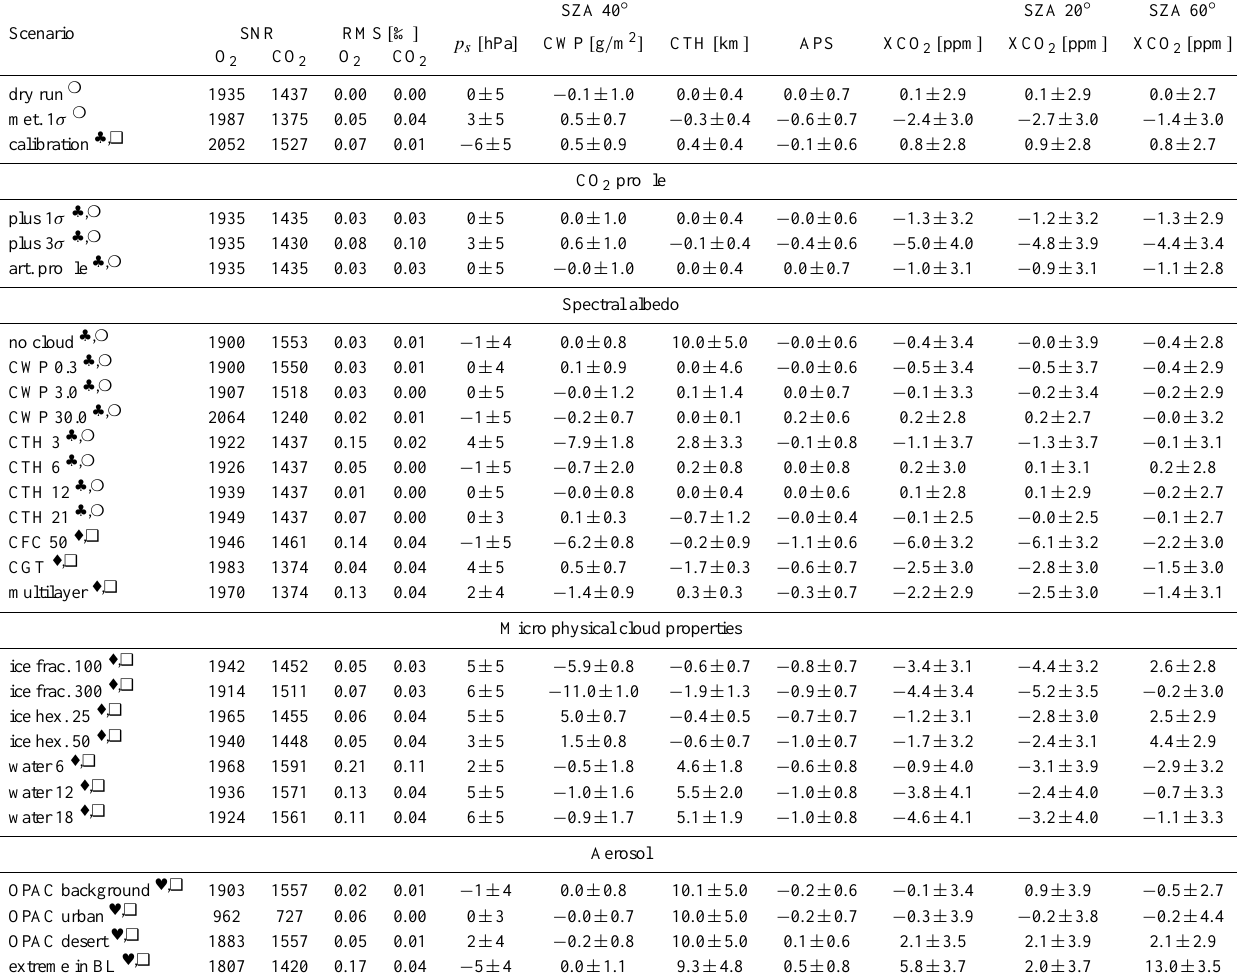
Table A2. As Table 2 but with an spectrally constant albedo of 0 .